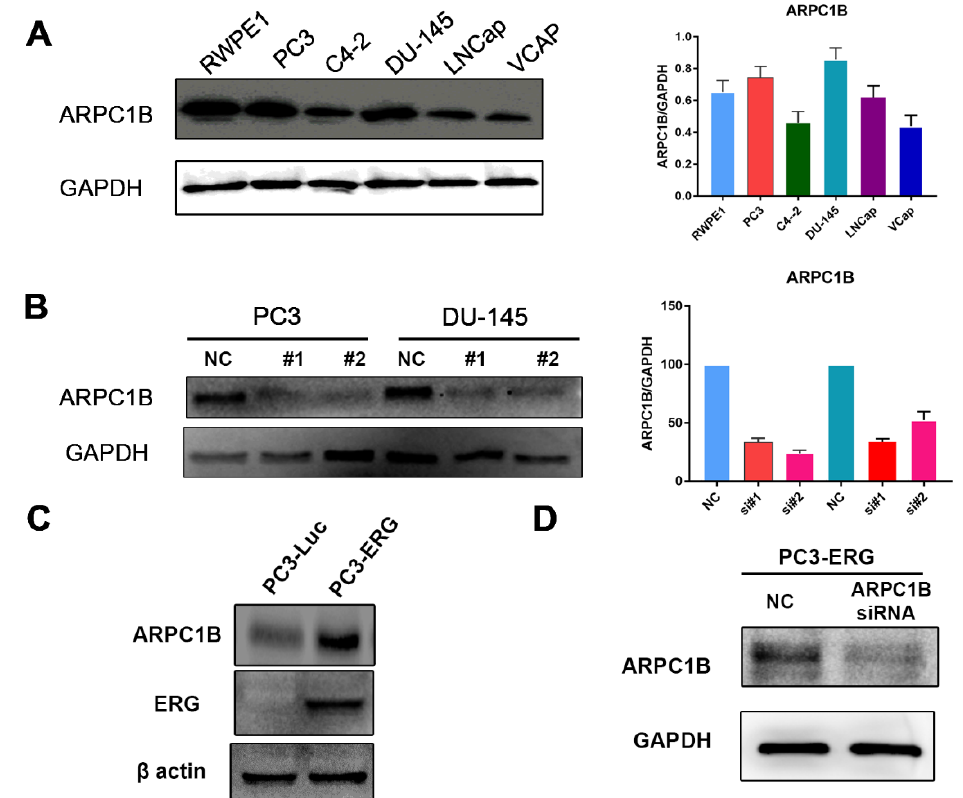
Figure 4. Expression of ARPC1B in PCa cell lines. ( A ) Western blot analysis of ARPC1B expression in PCa cell lines: RWPE1, PC3, C4-2, DU145, LNCaP, and VCAP. ( B ) Knockdown of PC3 and DU145 cell lines using ARPC1B siRNA#1, siRNA#2, or control scramble siRNA as the negative control. ( C ) The expression of ARPC1B in PC3-ERG overexpression cells ( D ) Western blot analysis of ARPC1B knockdown in PC3-ERG cells using ARPC1B, siRNA#1, or scramble siRNA as the negative